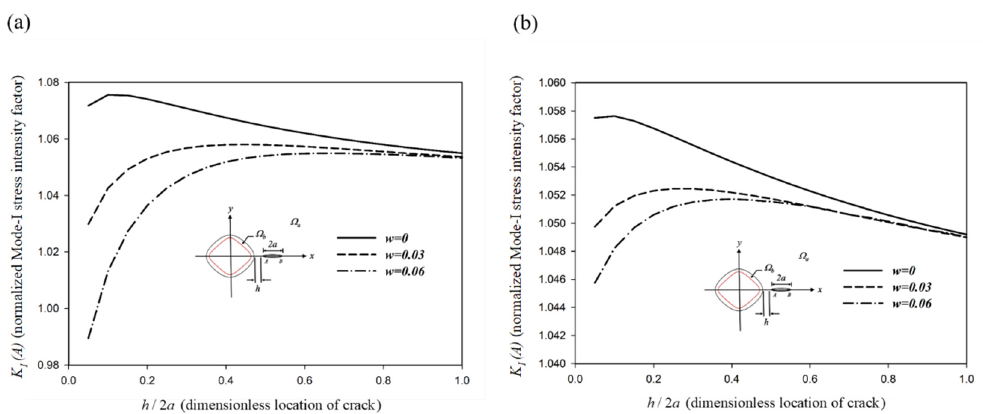
Figure 11. SIFs with different shape factors of an approximately square hole with an inclusion layer ( a ) at Tip A ( b ) at Tip B ( r = 1.05, G b /G a = ( a ) at Tip A ( b ) at Tip B ( r = 1.05, G